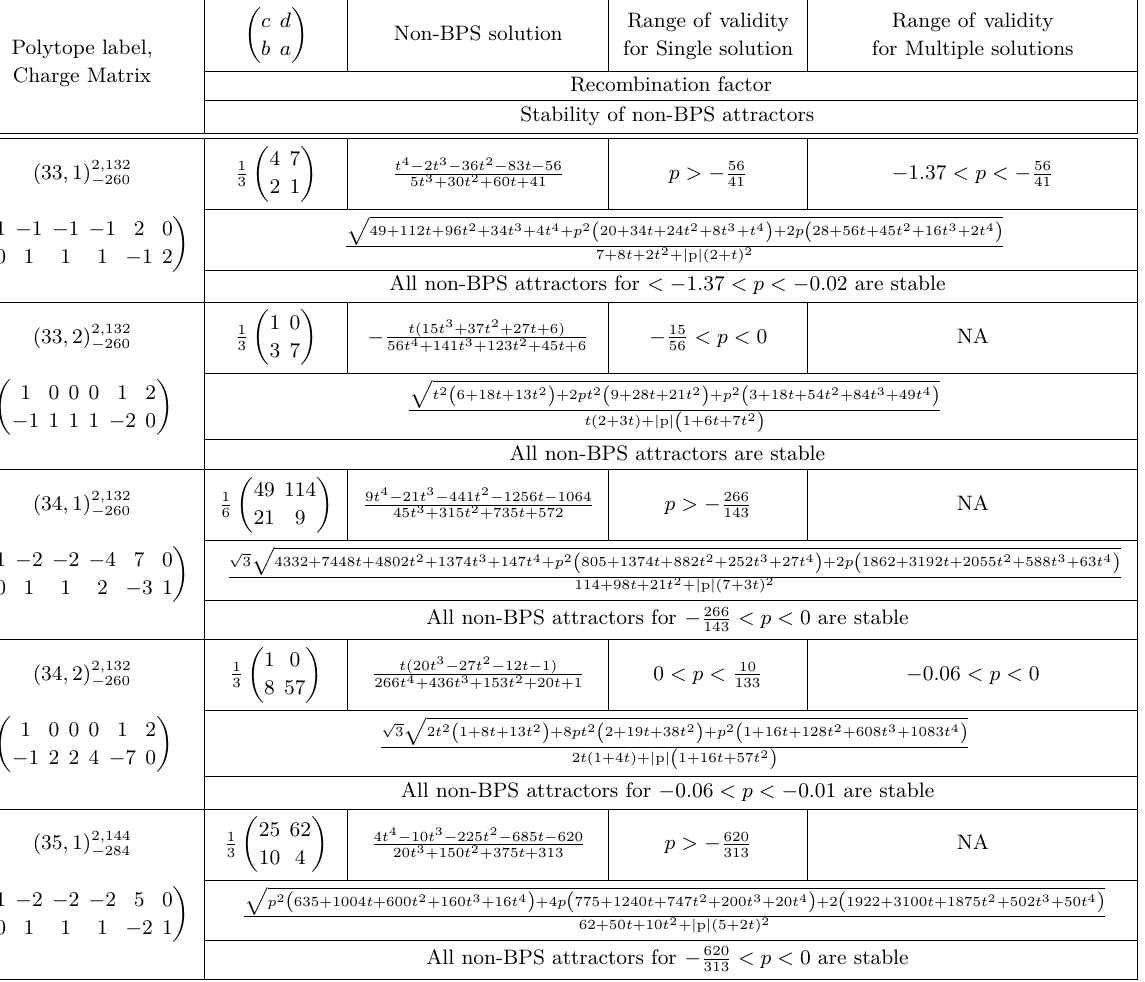
Table 18 . Non-BPS extremal (multiple) black strings in one-modulus THCY models,